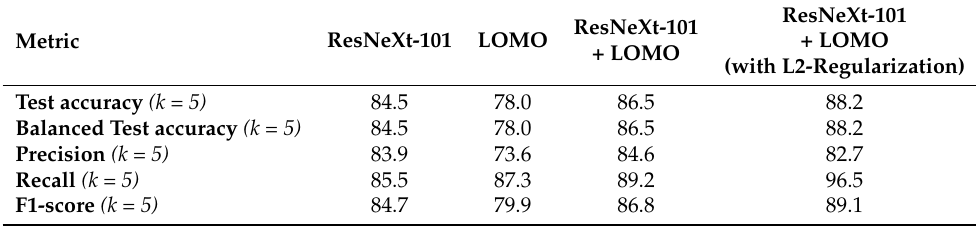
Table 4. Comparison of different proposed Siamese networks.